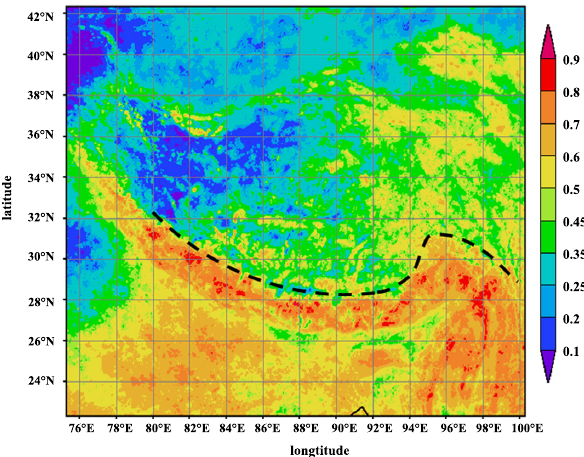
Figure 6. Mean distribution of cloud cover fraction in July 2008 (06:00UT) derived from the Chinese meteorological satellite FY- 2F. The black dash line separates the high and low amounts of cloud cover over the